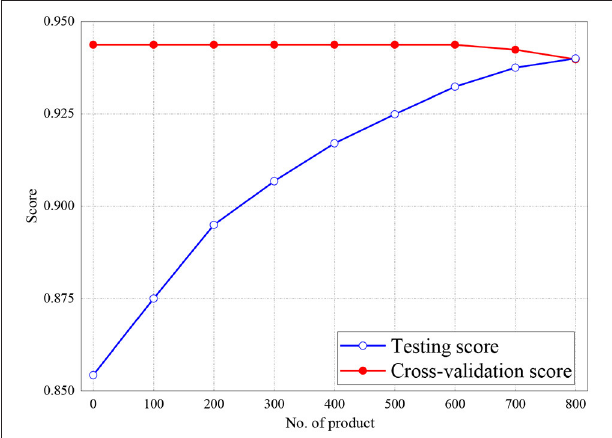
FIGURE 7 | Result for Testing and Cross-Validation of Logistic Regression.